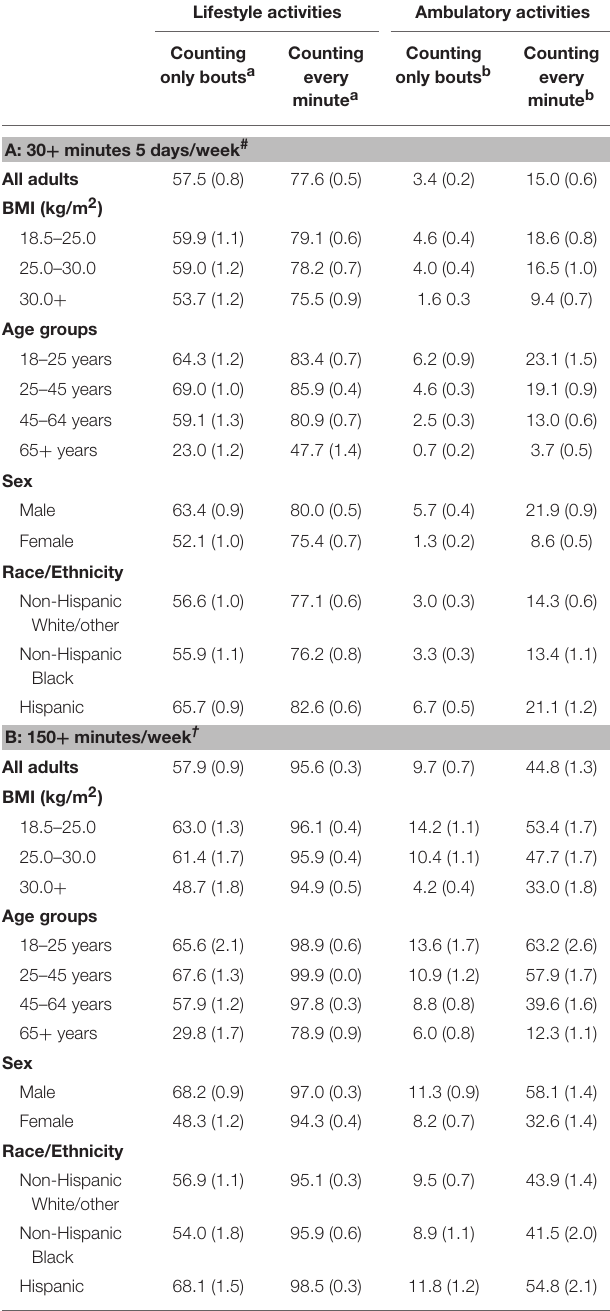
TABLE 2 | Prevalence* (% and SEM) of the population attainting sufficient #, † physical activity to meet public health